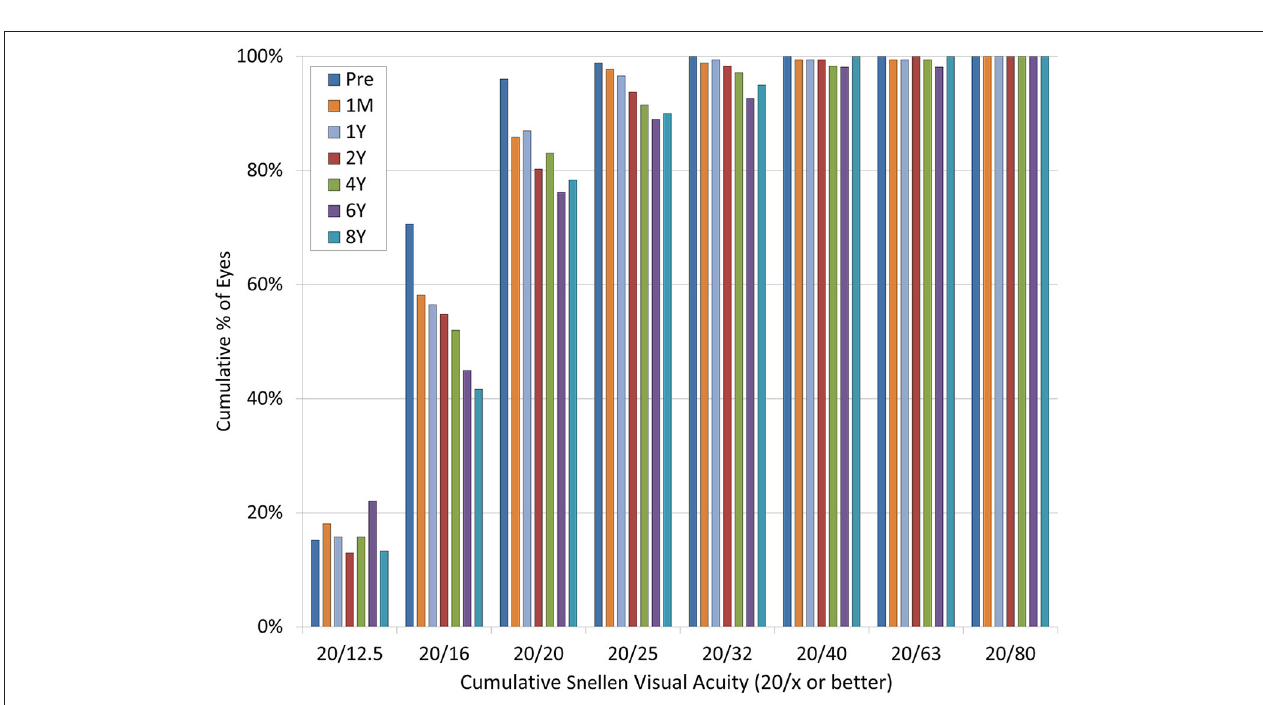
FIGURE 2 | Changes in uncorrected distance visual acuity (UDVA) after hole implantable collamer lens (EVO-ICL) implantation. postoperatively due to anterior subcapsular cataract vertical orientation due to a high non-toric ICL vault and a re- alignment due to a toric ICL rotation). Two eyes (1.1%) required simultaneous ICL extraction and cataract surgery at 2 and 3 years